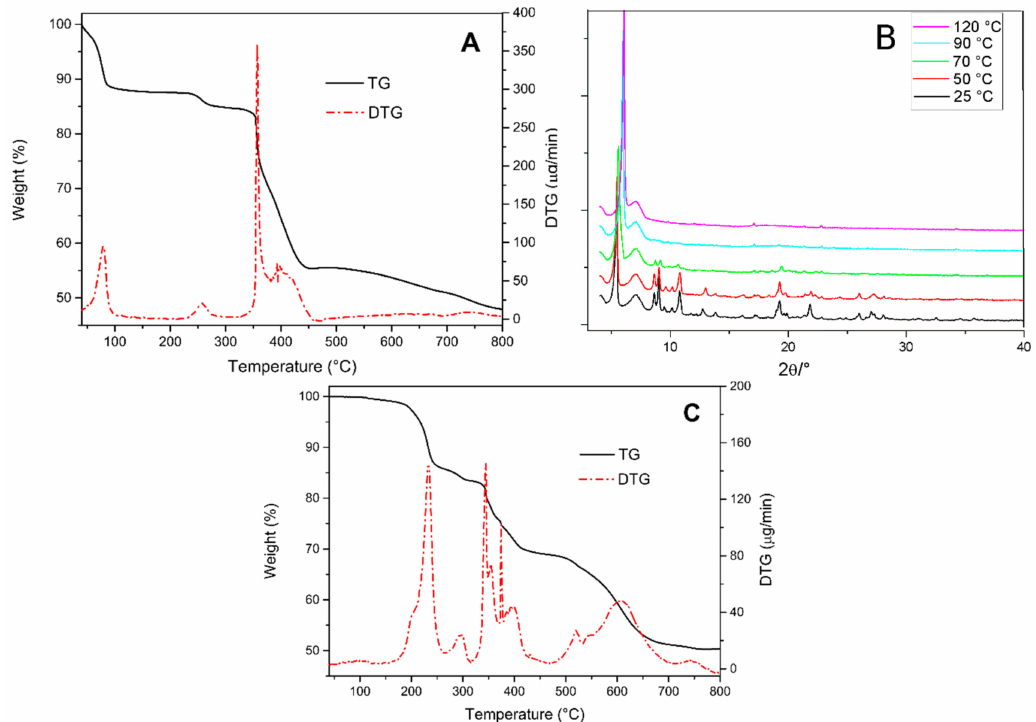
Figure 5. ( a ) TG / DTG curve of phase 1 ; ( b ) temperature-dependent X-ray powder di ff raction patterns for phase 1 , the peak between 6 ◦ and 8 ◦ 2 θ is due to the di ff raction of Kapton ® polymer used as window in the Anton-Paar Hot Chamber; ( c ) TG / DTG curve of phase 2